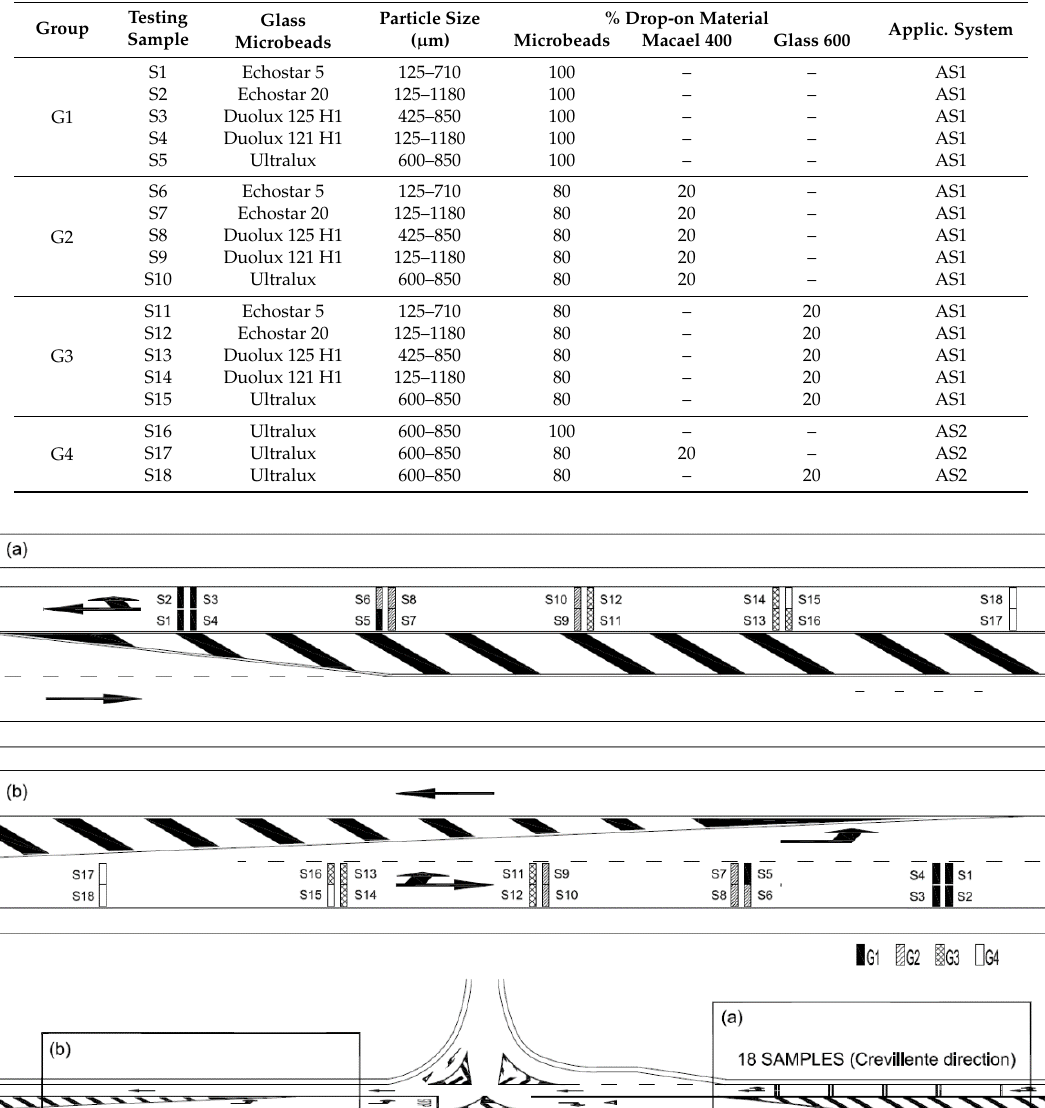
Table 11. Test samples composition and application system.